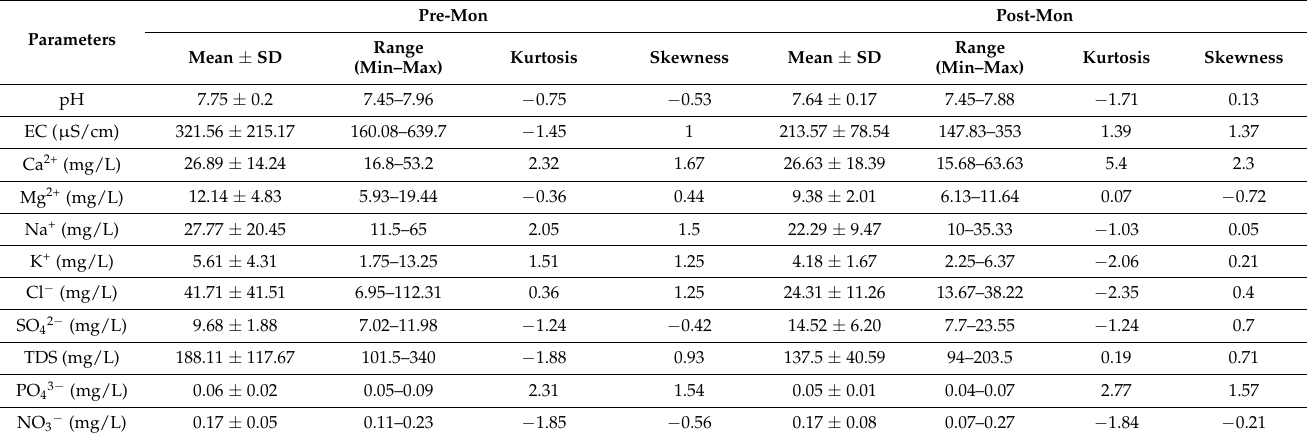
Table 3. Descriptive statistics of physicochemical parameters of surface